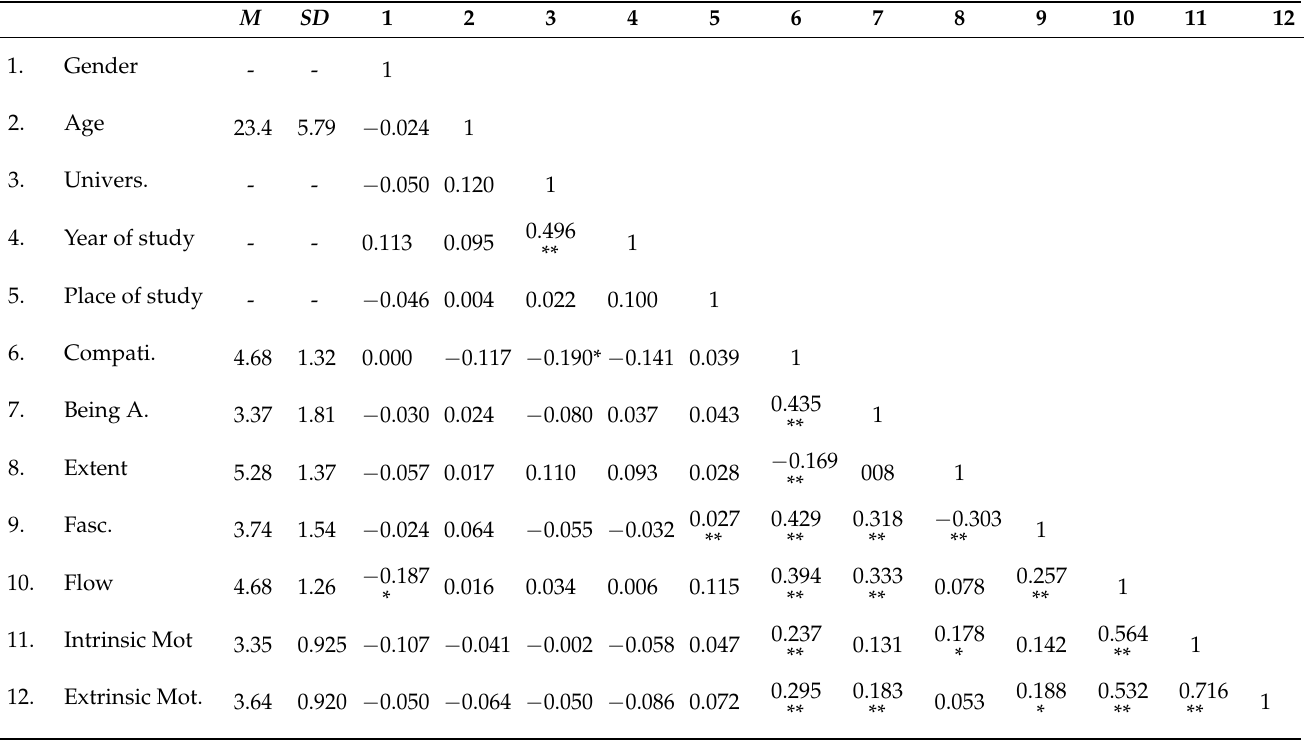
Table 1. Study Variables: Descriptive Statistics and Bivariate Correlations (N =